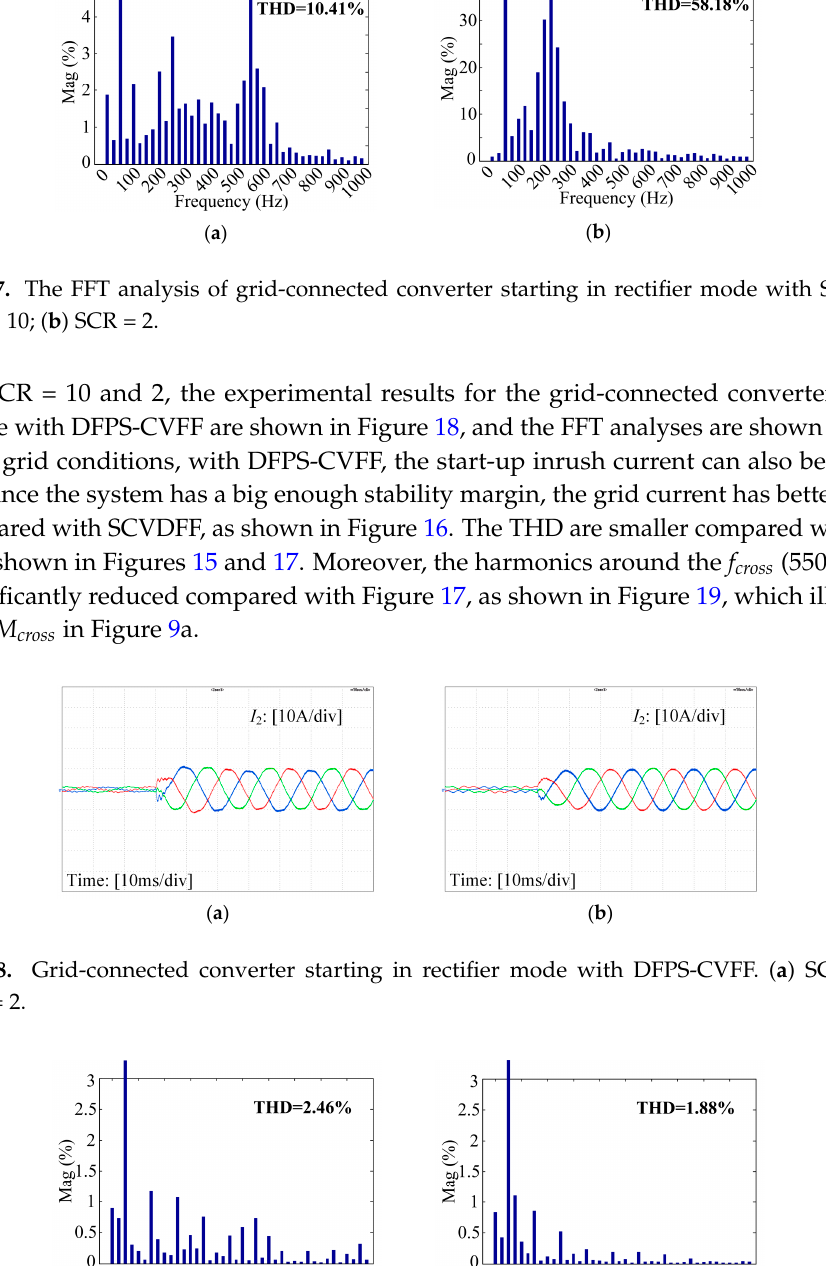
Figure 19. The FFT analysis of grid-connected converter starting in rectifier mode with DFPS-CVFF. ( a ) SCR = 10; ( b ) SCR = 2.